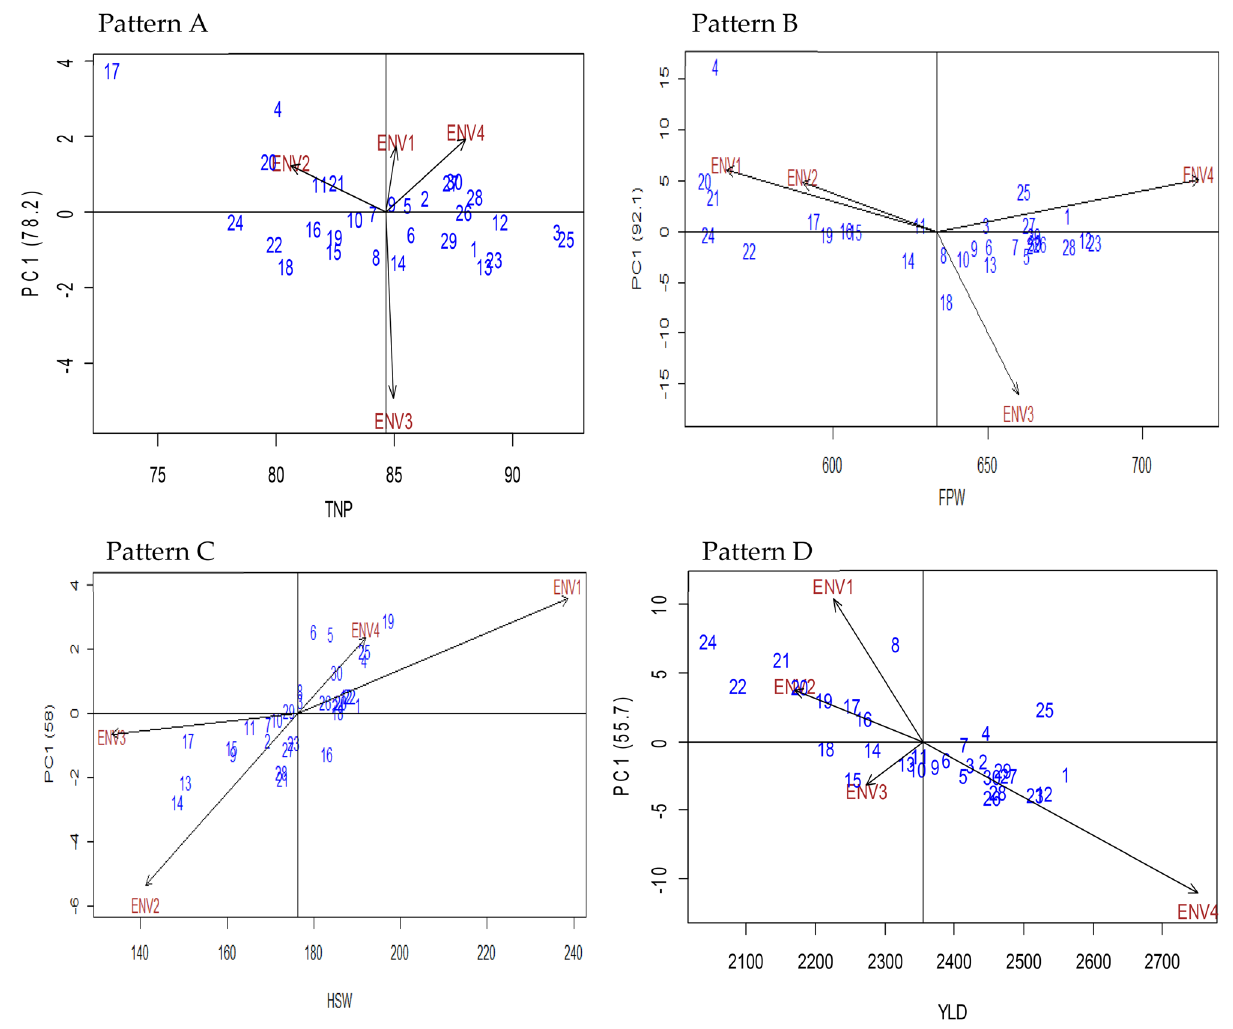
Figure 7. The biplot ‘AMMI 1’ illustrated the trait main effect and first principal component (PC1) effects of both genotype and environment of 30 V . subterranea genotypes under two season two location for total number of pods (Pattern A), fresh pod weight (Pattern B), hundred seed weight (Pattern C), yield per hectare (Pattern D). The biplots were created based on Centering = 0, SVP = 2, Scaling = the biplot origin is regarded as winning genotypes in the environments that fall in that sector. The extent of interaction revealed by the environment over the genotype and vice versa is controlled by the distance of the environment and genotype vectors that originated from the origin of the biplot. In our study, we found ENV4 for TNP (Fig. 8: Pattern A), ENV2 for FPW (Fig. 8: Pattern B), ENV3 for HSW (Fig. 8: Pattern C), and yield per hectare (Fig. 8: Pattern D) had short vector comparatively other environments. As a report by Murphy et al . 47 the environment indicator with a shorter vector i.e., nearer to biplot origin is less interactive and treated as a perfect index for selecting genotype with mean performance and adaptability. Most of the genotypes for the traits TNP, FPW, HSW, and Yield per hectare were assembled (Fig. 8: Pattern A, B, C, D) close to the biplot origin. How- ever, genotypes that assembled or cluster together on the biplot origin indicating that genotypes have identical feedback to all tested environments compared to the genotypes that are positioned away from each other, this statement is corroborated with the report of Akter et al. 50 . Moreover, genotypes that are placed apart for biplot origin are more sensitive to environmental interaction related to closely positioned genotypes to biplot origin. The correlation coefficient and the degree of interaction of genotype and environment can be highlighted by the angle between the vectors of environment and genotype. There was no correlation when environment and genotype form a right-angle while the severe and nearer angle between them indicates negative and positive cor- relation, respectively. The findings in this current investigation have authorized statements reported by Oladosu et al . 19 using two seasons five locations. Evaluation of genotypes. In this study, the evaluation of the selected genotype for yield and its positively correlated contributing trait’s stability over a wide range of environments are justified through the result of a significant test of GE interaction.